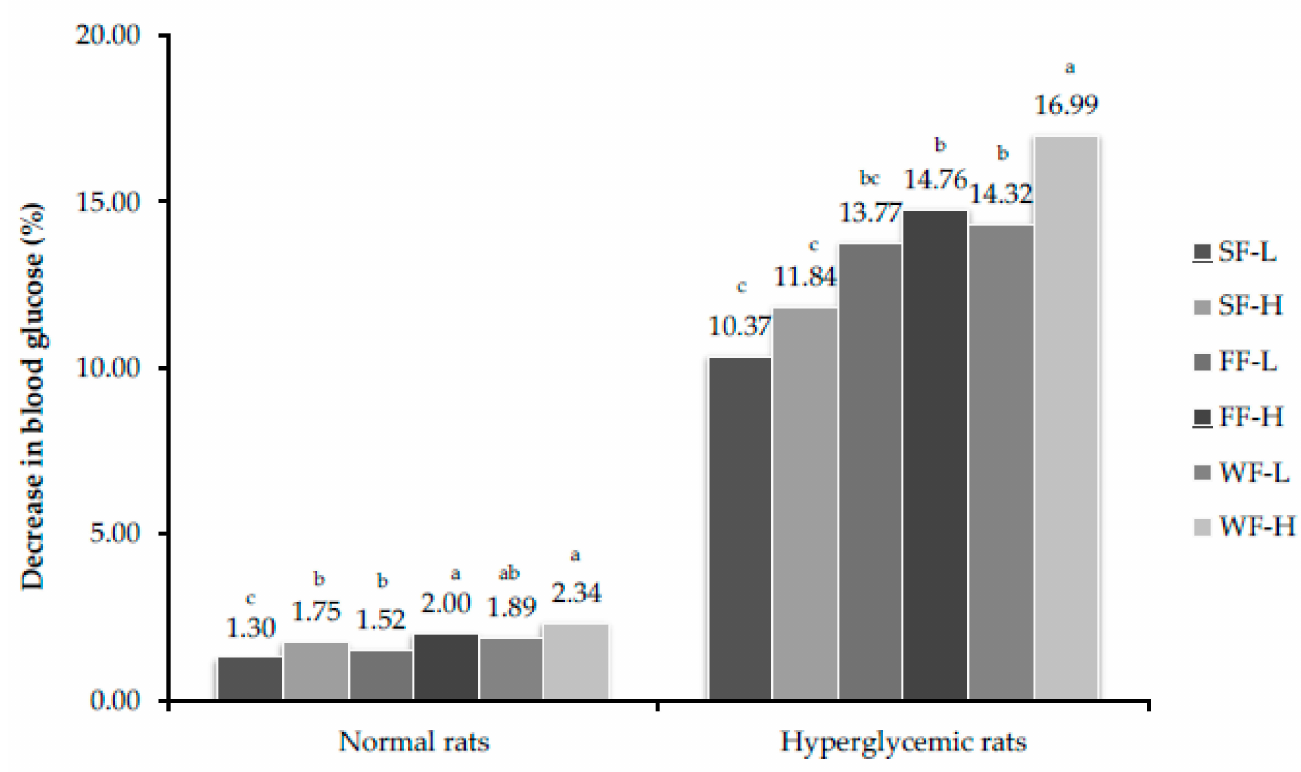
Figure 2. Percent decrease in glucose level after feeding bitter gourd on 28th day. Bars that do not share similar letters denote statistical significance ( p <